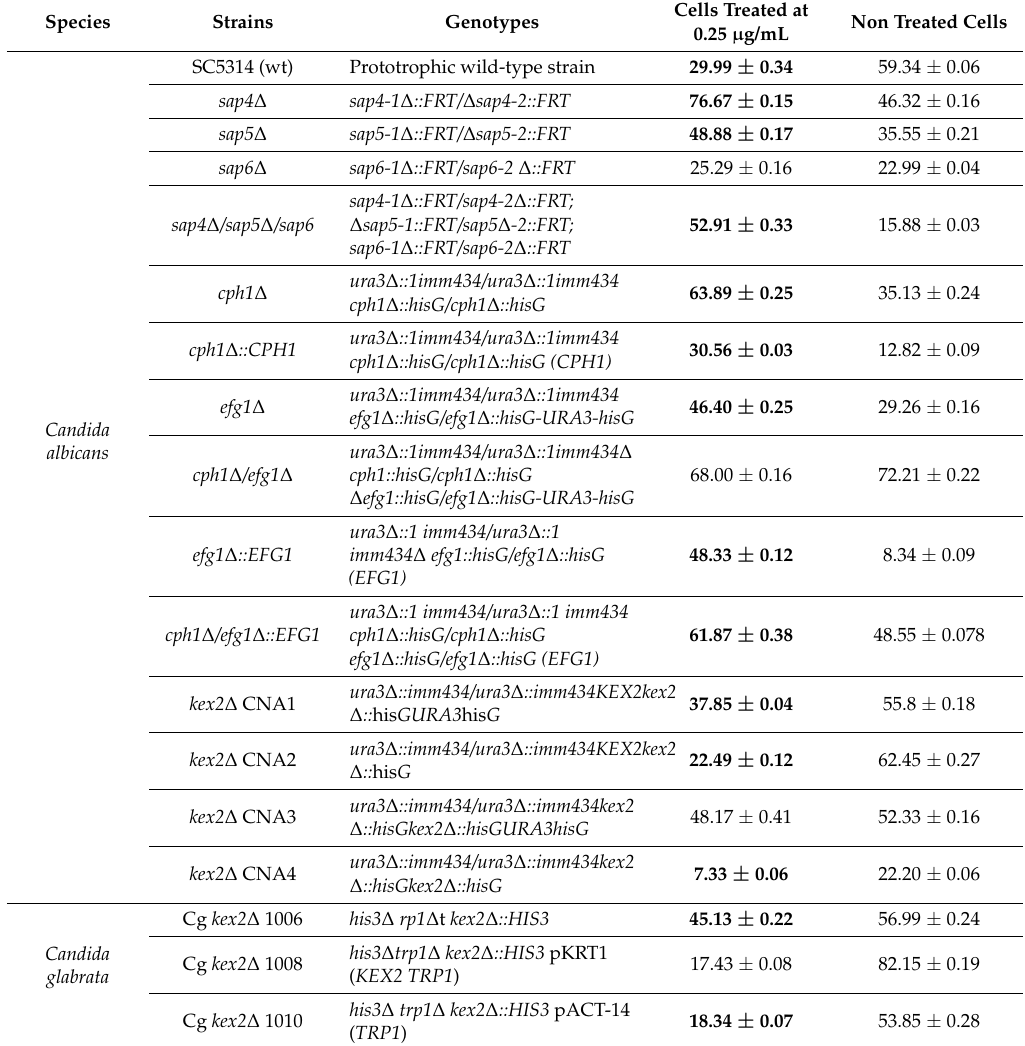
Table 4. The percentage of adhesion of Candida cells to the Caco-2 cell line after pre-treatment with 2-bromo-2-chloro-2-(4-chlorophenylsulfonyl)-1-phenylethanone (named Compound 4 ). Adhesion data was calculated for cells grown on Sabouraud agar of a 24-well-plate. Adherence was expressed as a percentage of the total number of cells added (control cells non-treated). Data are expressed as the mean ± SD of three independent experiments. Values in bold indicate significantly affected adhesive properties compared to the non-treated counterparts ( p ≤